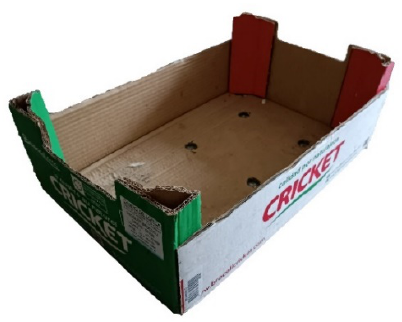
Figure 1. Selected example of an open-top box for the transport of fruits or vegetables.